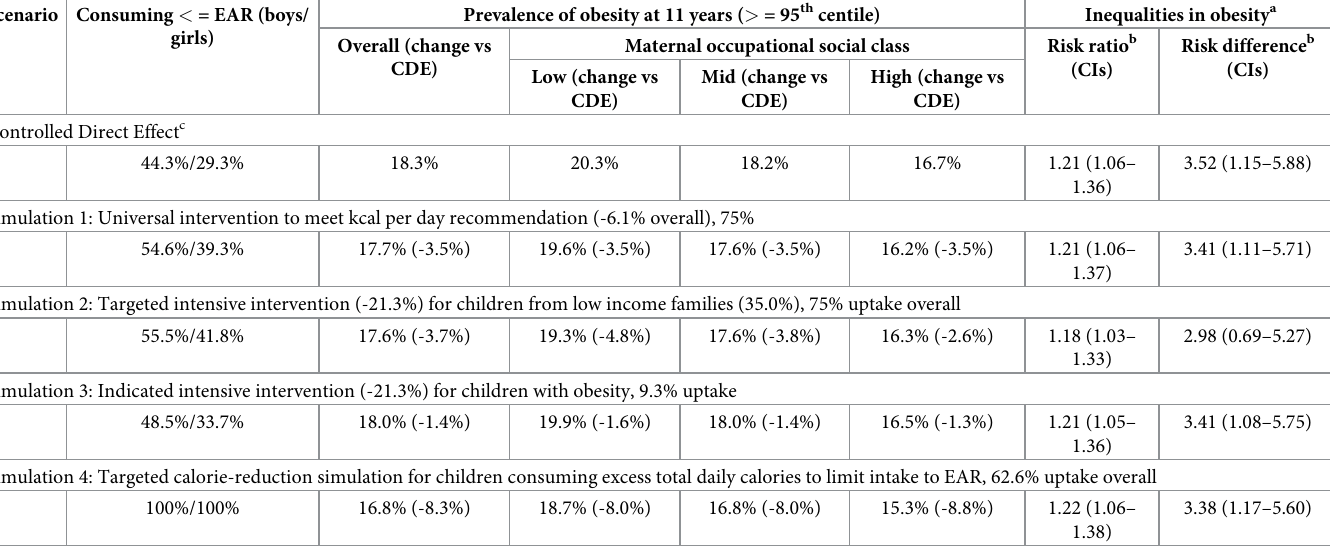
Table 3. Prevalence of obesity at age 11 years by maternal social class with risk ratios and differences for relative and absolute inequalities, for intervention scenar- ios 1–6. Scenario Consuming < = EAR (boys/